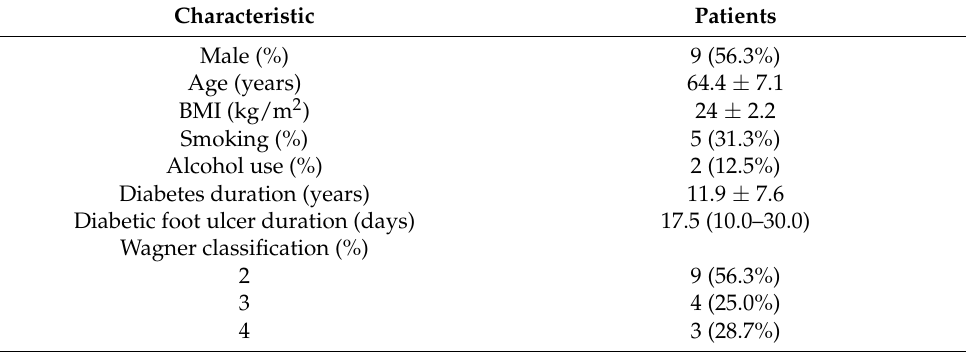
Table 1. Clinical characteristics of 16 patients with unilateral diabetic foot